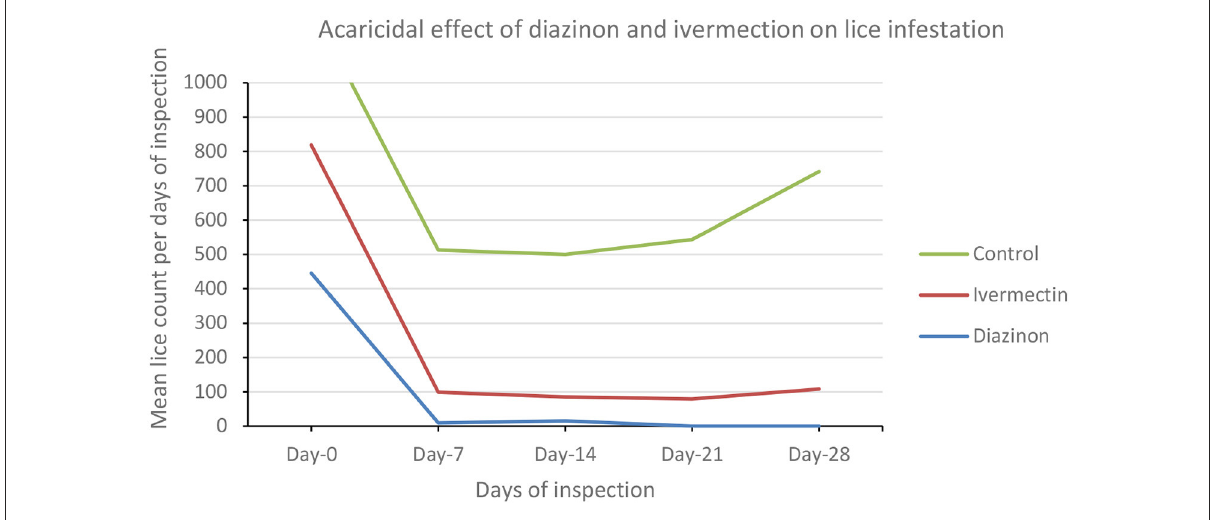
FIGURE4 Line graph showing the trends of lice infestation (mean lice count) across treatment groups.